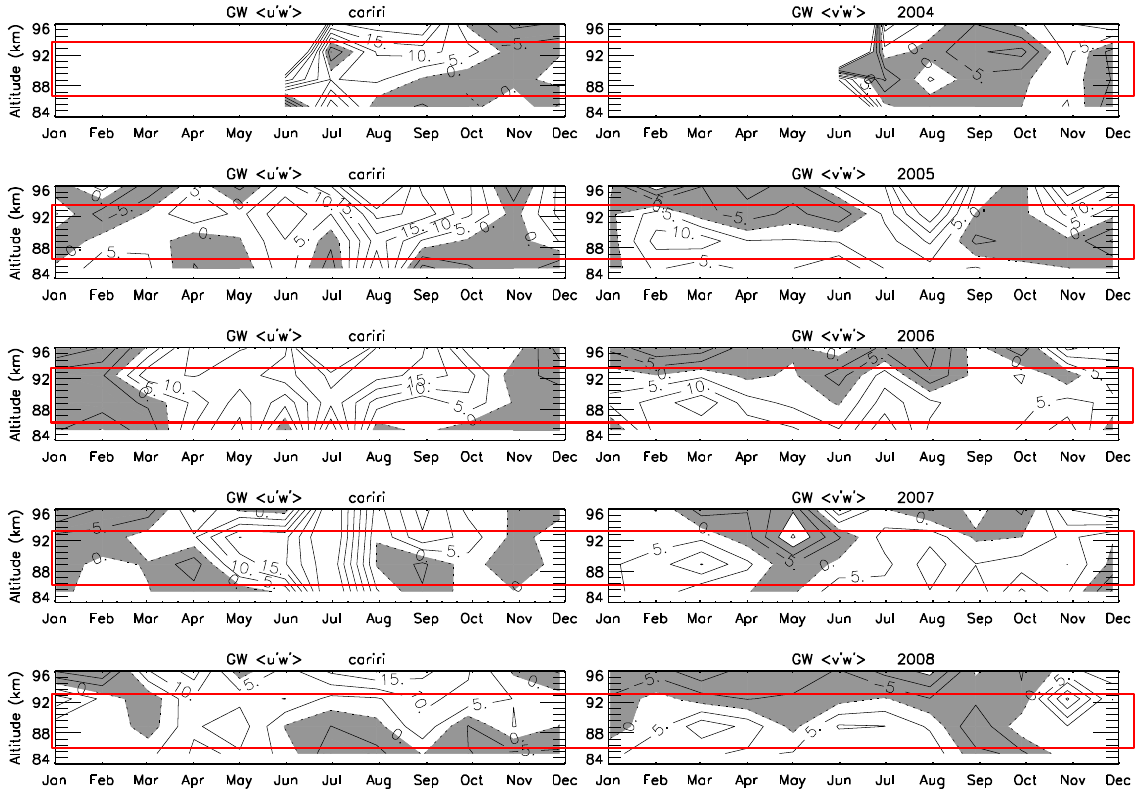
Figure 1. Monthly mean vertical profiles of GW momentum fluxes from 2004 (top) to 2008 (bottom): zonal (left) and meridional (right) components. Each contour corresponds to 5m 2 s − 2 ; the white areas represent positive values and grey the negative. Dashed lines show where the values are zero. These panels represent the results for Cariri from 2004 to 2008.